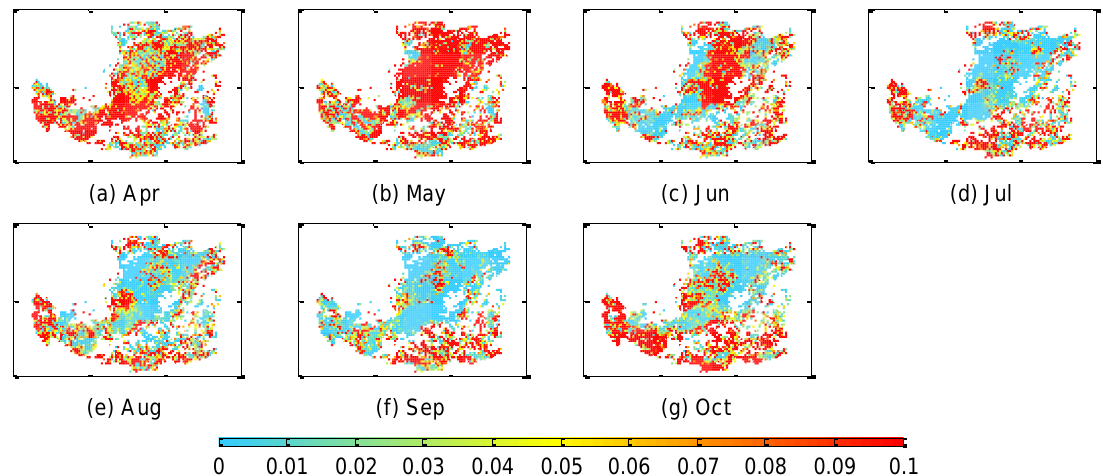
Figure 13. The significance level of a linear regression between NDVI and precipitation in different months.